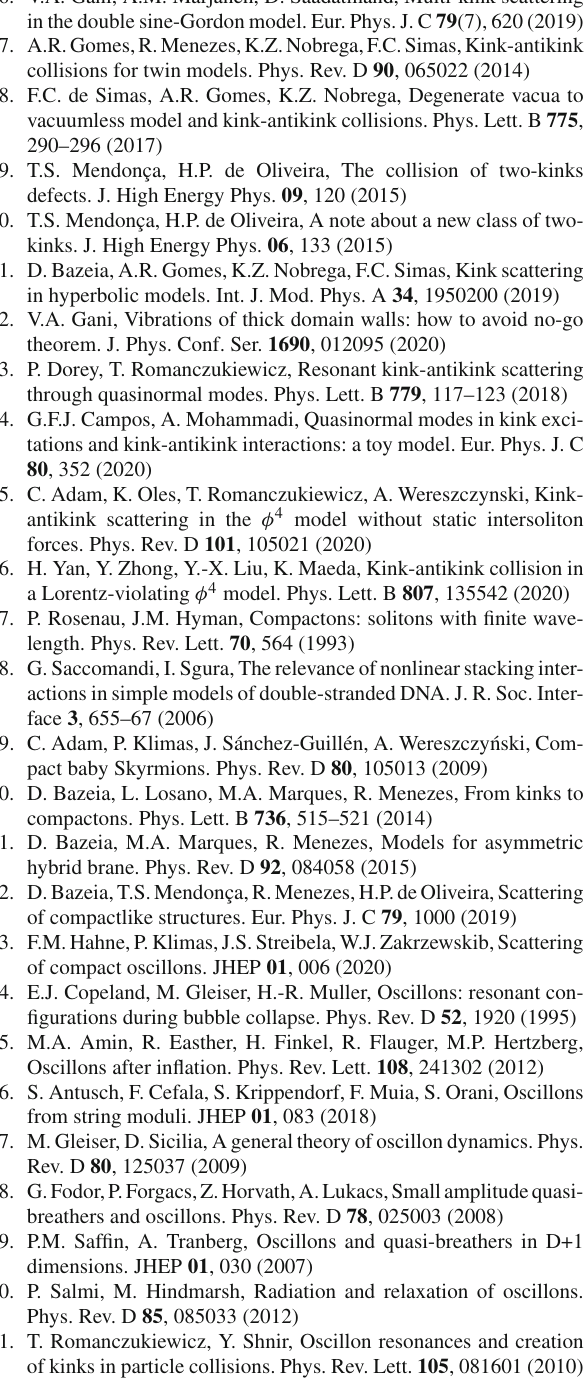
figurations during bubble collapse. Phys. Rev. D 52 , 1920 (1995) 75. M.A. Amin, R. Easther, H. Finkel, R. Flauger, M.P.